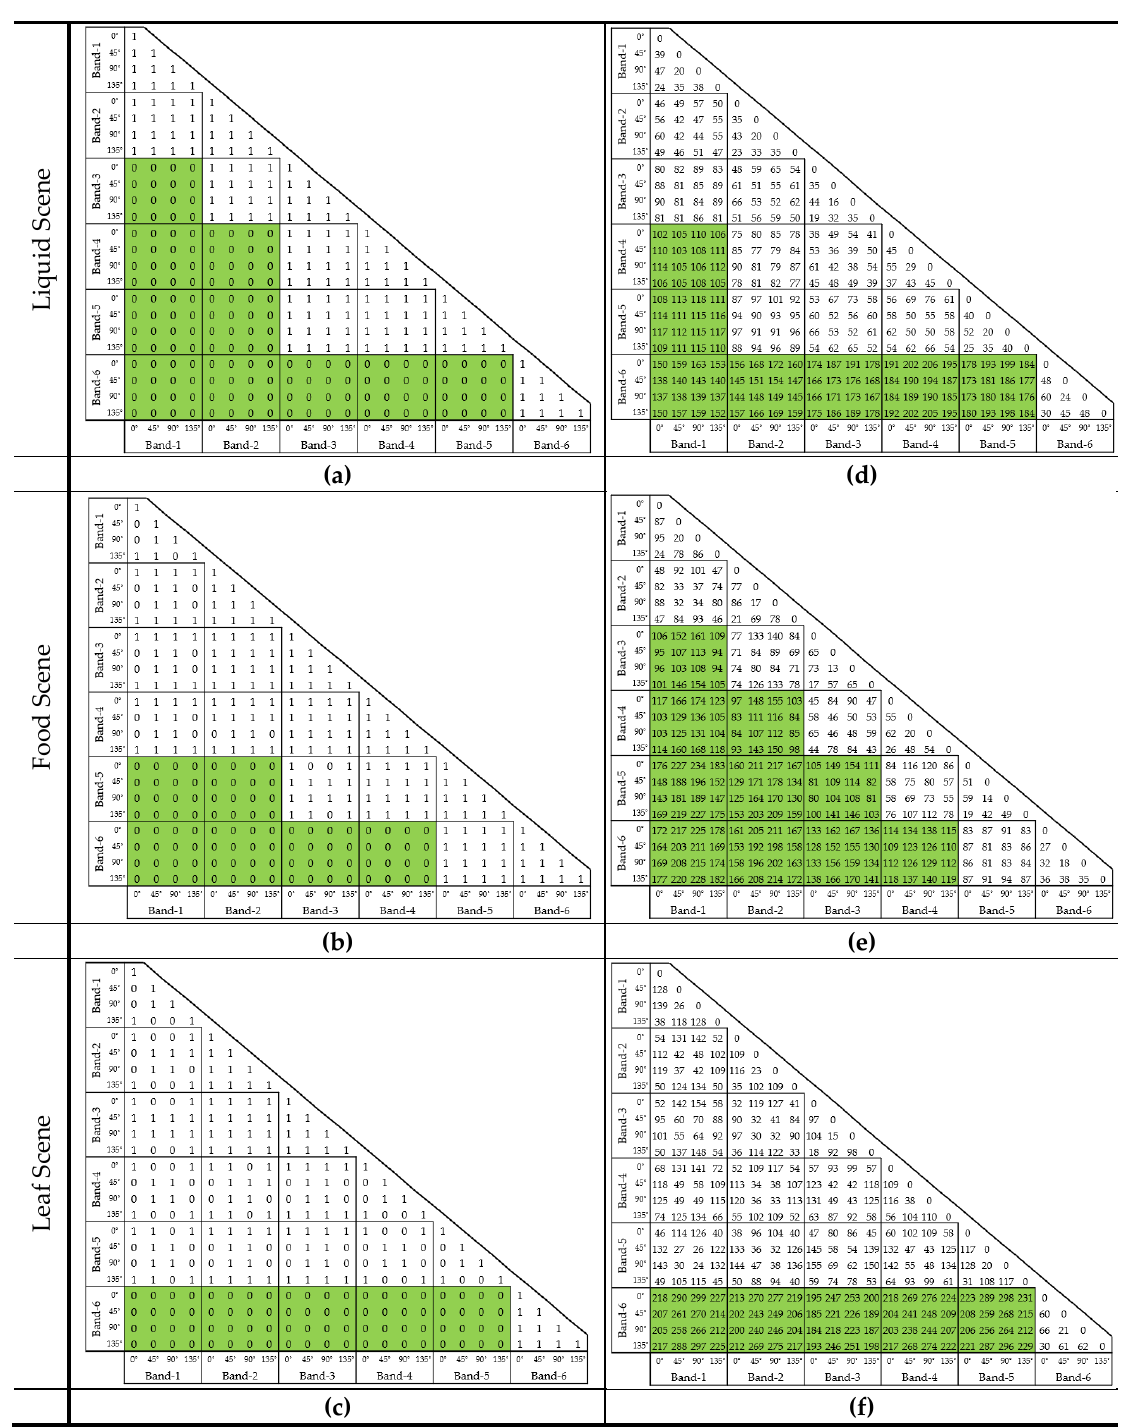
Figure 3. Multiband dissimilarity matrices for three scenes: ( a-c ) Pearson correlations; and ( d-f ) Euclidean distances.